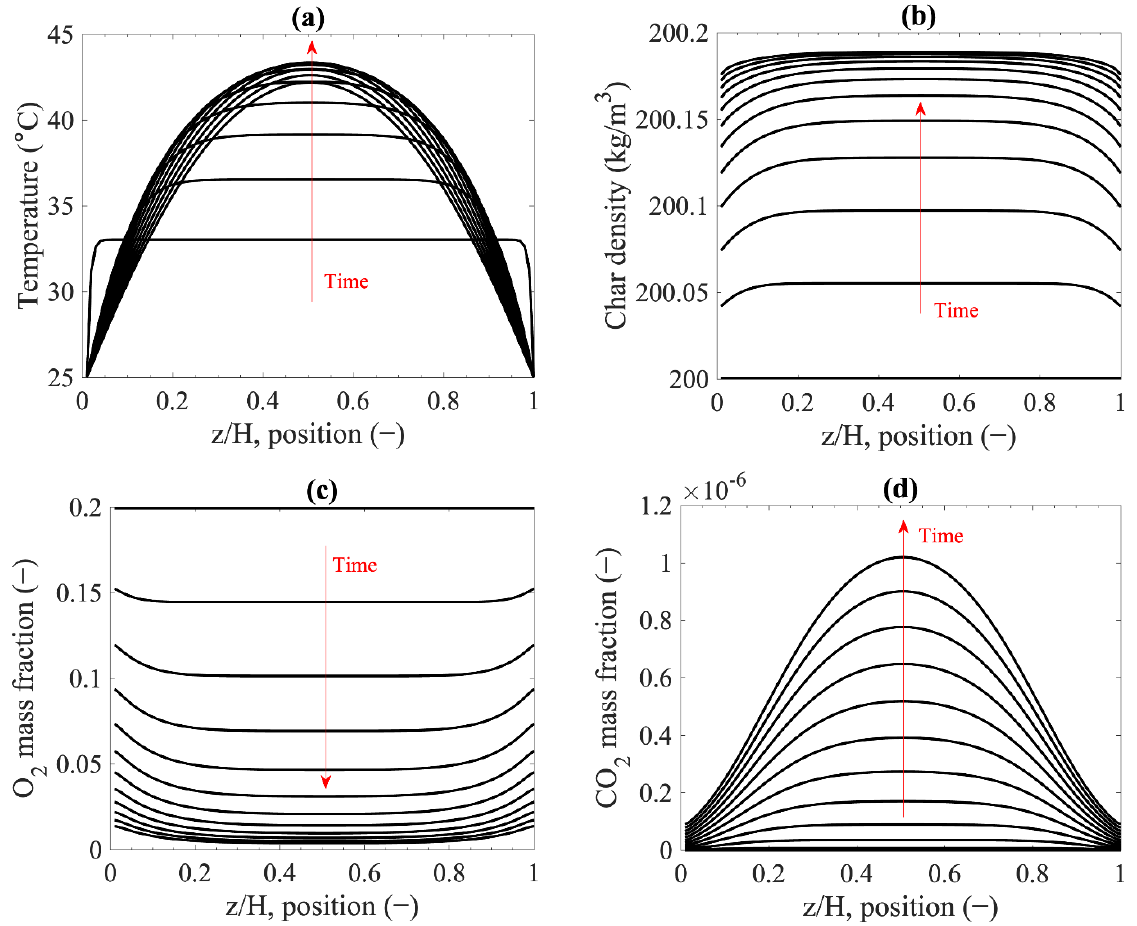
Figure 5. Evolution of local properties over time with the interval of 100 min (Conditions: T 0 = 33 °C, T ambient = 25 °C, ρ c ,0 = 200 kg m − 3 , and H container = 1 m): ( a ) Local temperature; ( b ) char density; ( c ) O 2 mass fraction; ( d ) CO 2 mass